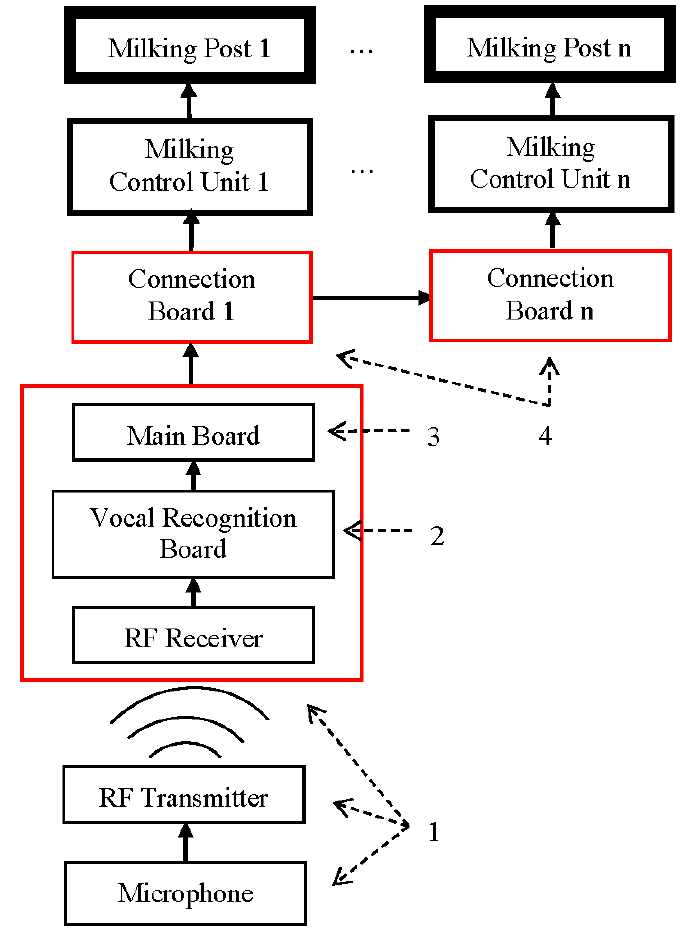
Figure 1. Hardware layout—connection scheme of the electronic components of the device. The device includes: (1) a microphone, a Radio Frequency (RF) transmitter, and receiver; (2) a vocal recognition board; (3) a main board; (4) a connection board for each milking post connected, made by Arduino UNO, and a specialized relay module. In red are shown the boxes where the electronic components of the device were placed in order to connect the system to the existing milking machine.